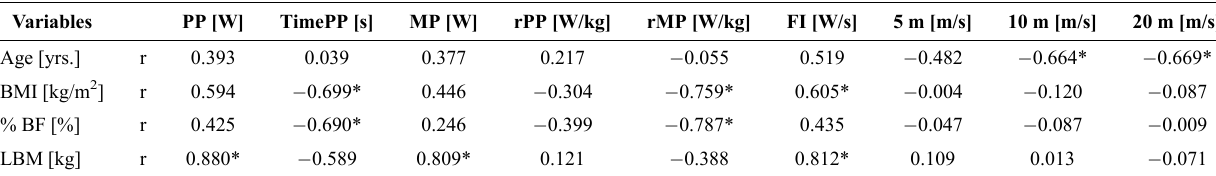
Table 3 - Correlation coefficient between age, body composition, and between results of the WAnT and the velocity in 20-m sprint test (n = 11).